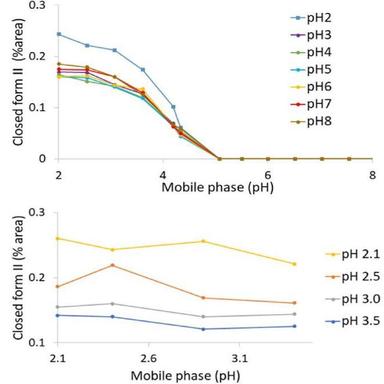
Top: AZD5718 in different pH sample solutions analysed with LC with mobile phase at different pH shows the pH dependences of the tautomer equilibrium, detected closed form II is presented. Bottom: AZD5718 in sample solutions at pH around pKa of the molecule run on LC with mobile phases with pH around pKa as shows increased levels of ring-closed tautomers in pH below pKa.